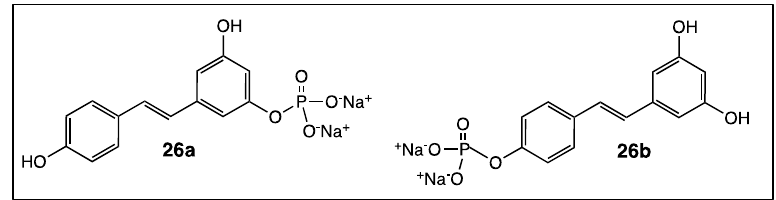
Figure 14 . Structure of O -phosphorylresveratrol derivatives 26a – b. Figure 14. Structure of O -phosphorylresveratrol derivatives 26a – b .